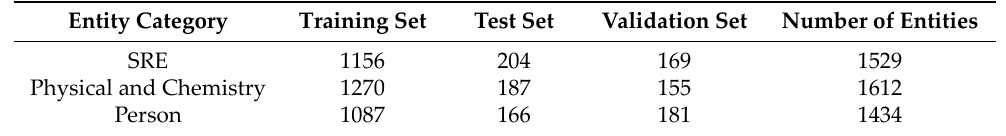
Table 4. Named entity dataset.